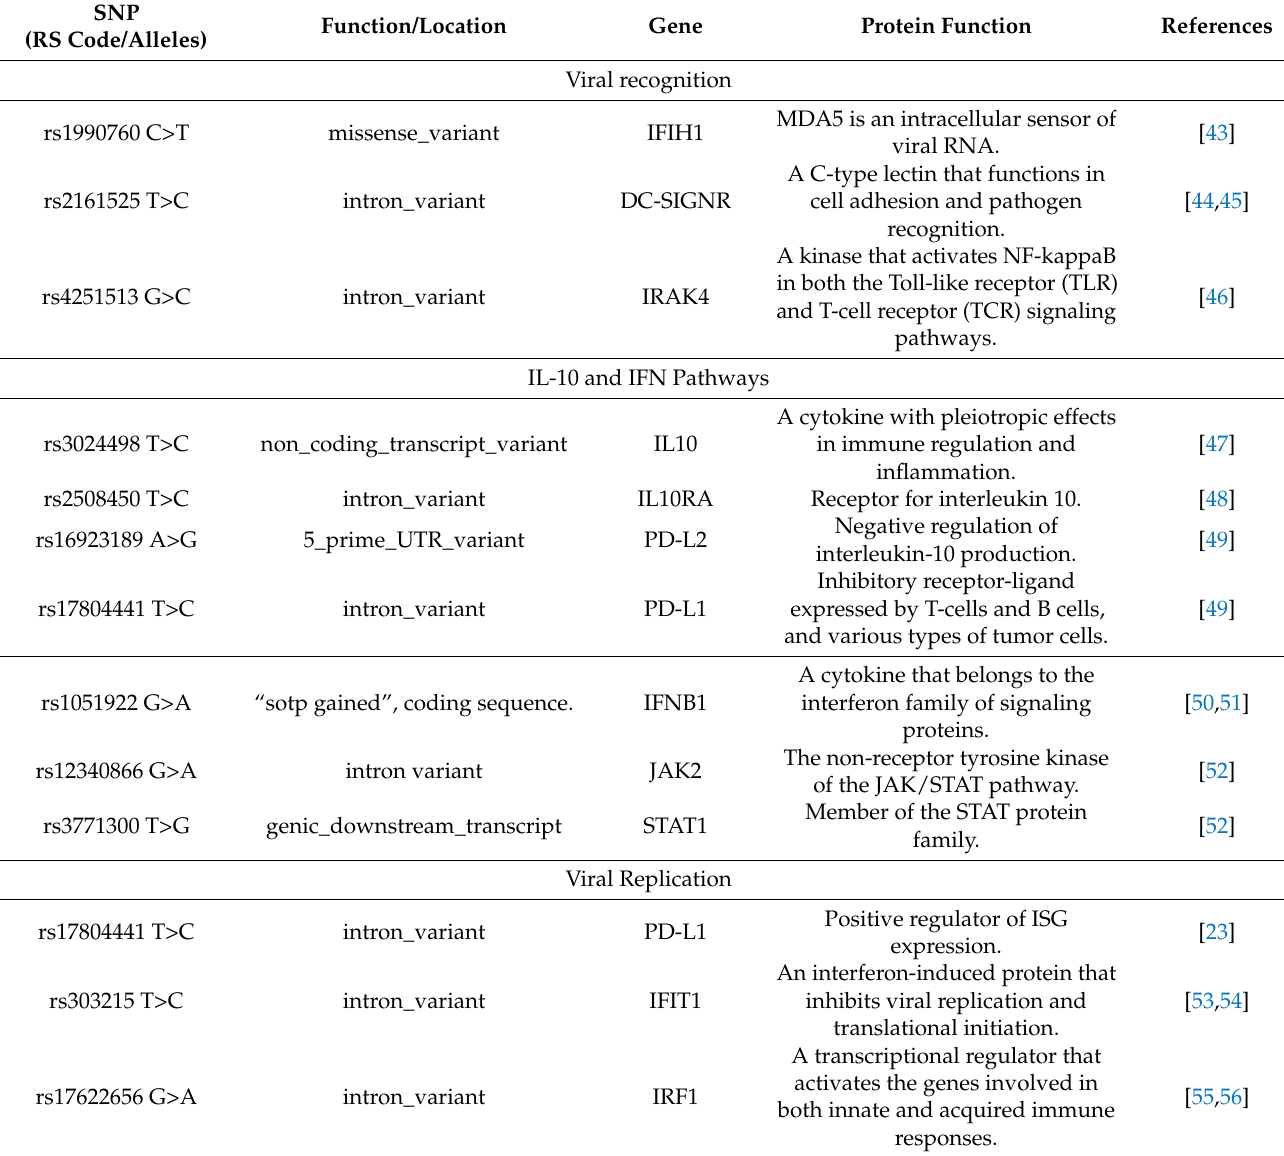
Table 2. The best 12 selected SNVs used in our genome polymorphisms/machine learning complex classifier for COVID-19